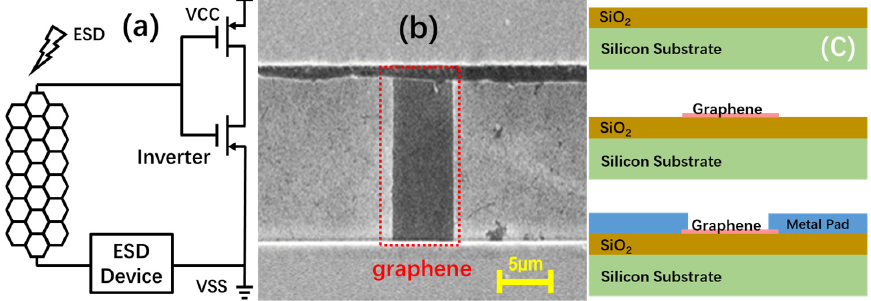
Figure 17. Graphene ESD interconnects: ( a ) an on-chip ESD protection scheme using GR wires as alternatives to metal wires; ( b ) SEM image for a GR sample with L = 12 µm and W = 5 µm; ( c ) CMOS- compatible fabrication in 3 main steps.